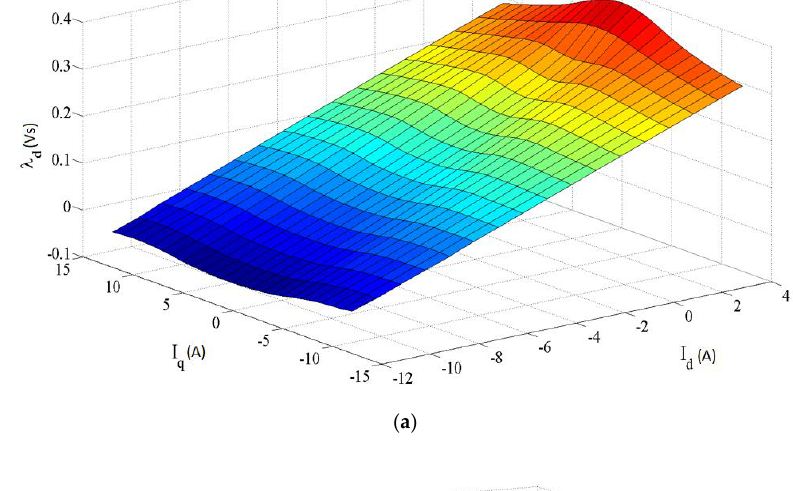
Figure 2. Equivalent block diagram of the position estimation algorithm considered for dynamics design of the loop shown in Figure 1.